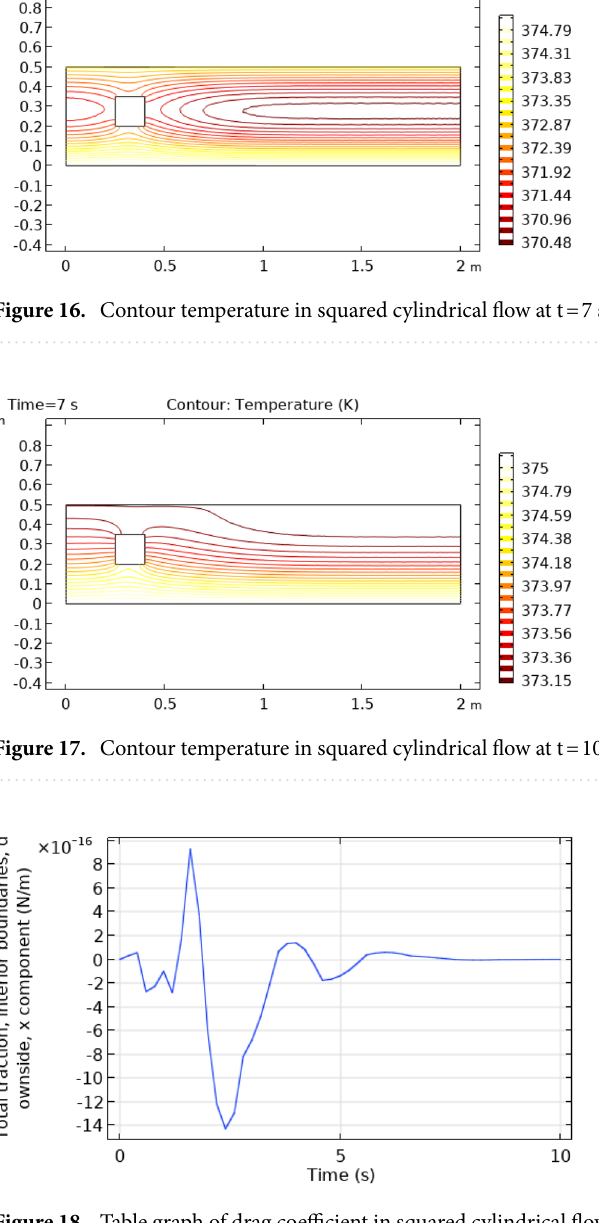
Figure 18. Table graph of drag coefficient in squared cylindrical